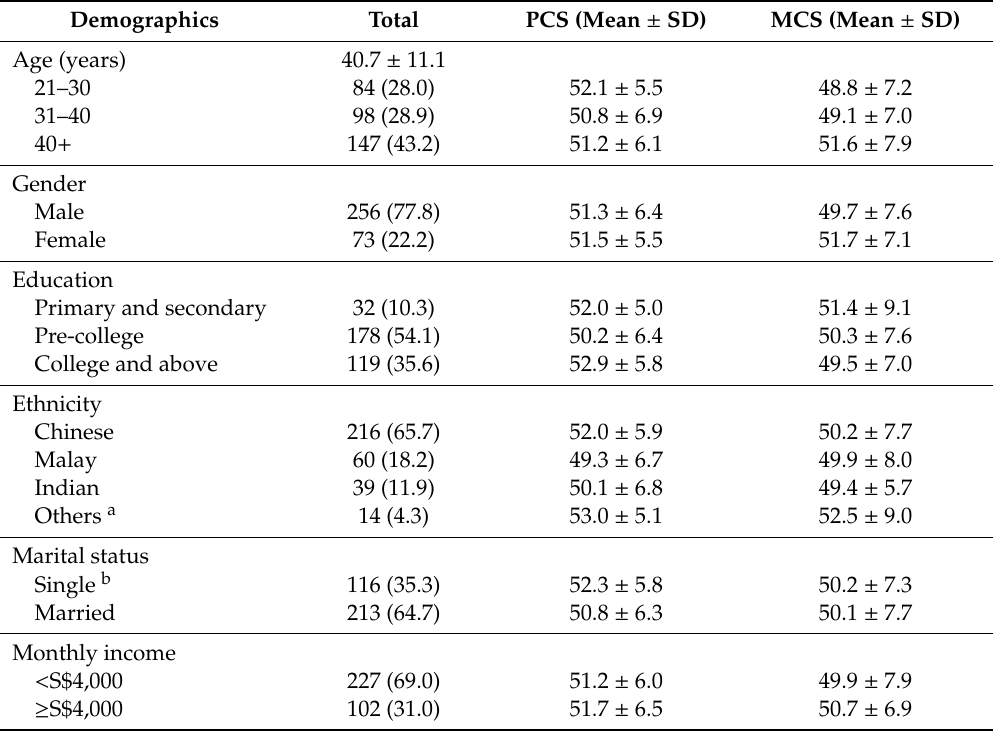
Table 1. Characteristics of study participants and physical component summary (PCS) and mental component summary (MCS)